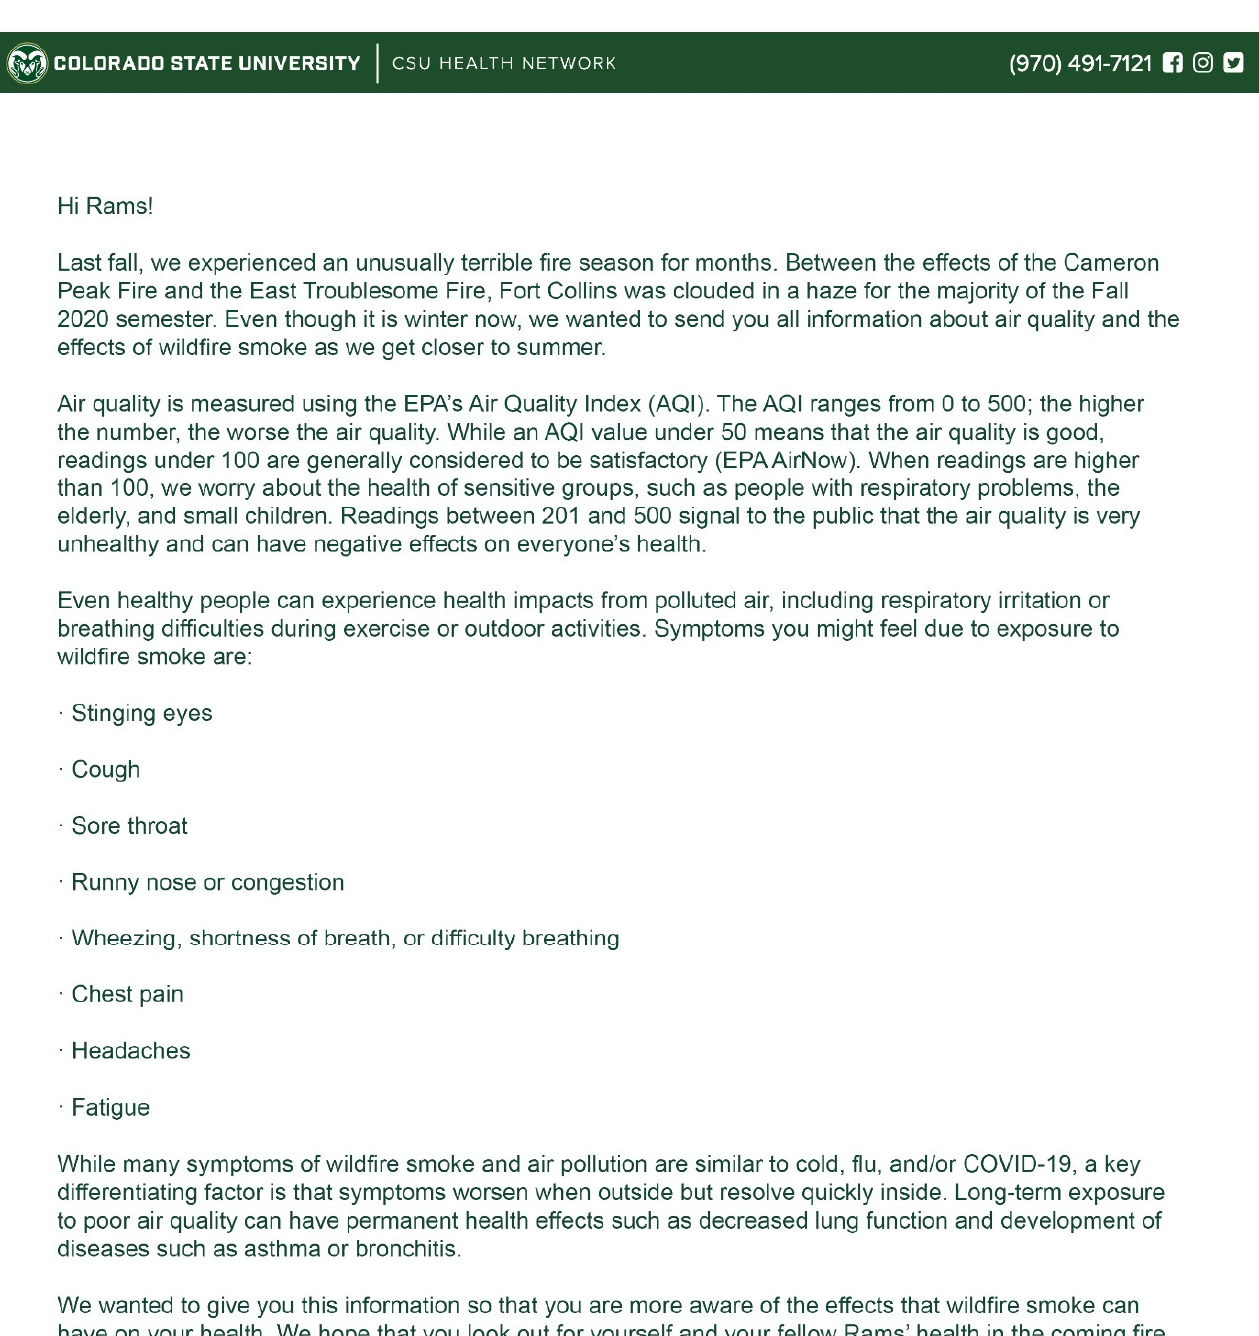
Figure A2. Low-efficacy, text-based stimuli.